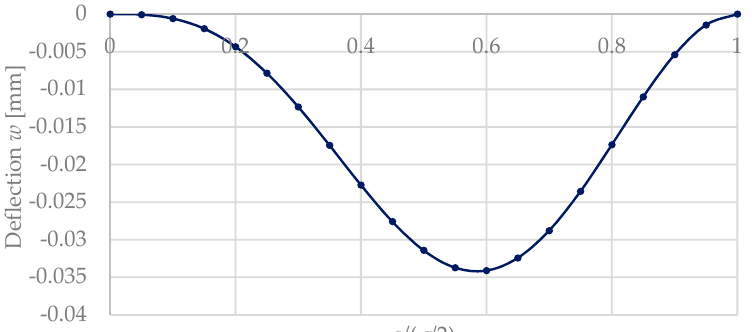
(cid:16) (cid:17) , (cid:3029) ) with (cid:1853) = (cid:1854) of a square plate calculated with